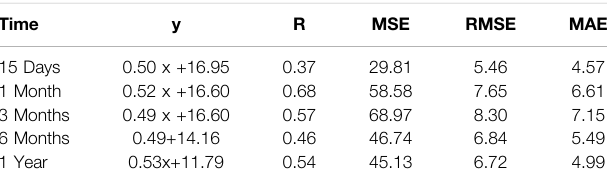
TABLE 4 | NO 2 2020 model performance statistics with different time period in Jiangsu Province.